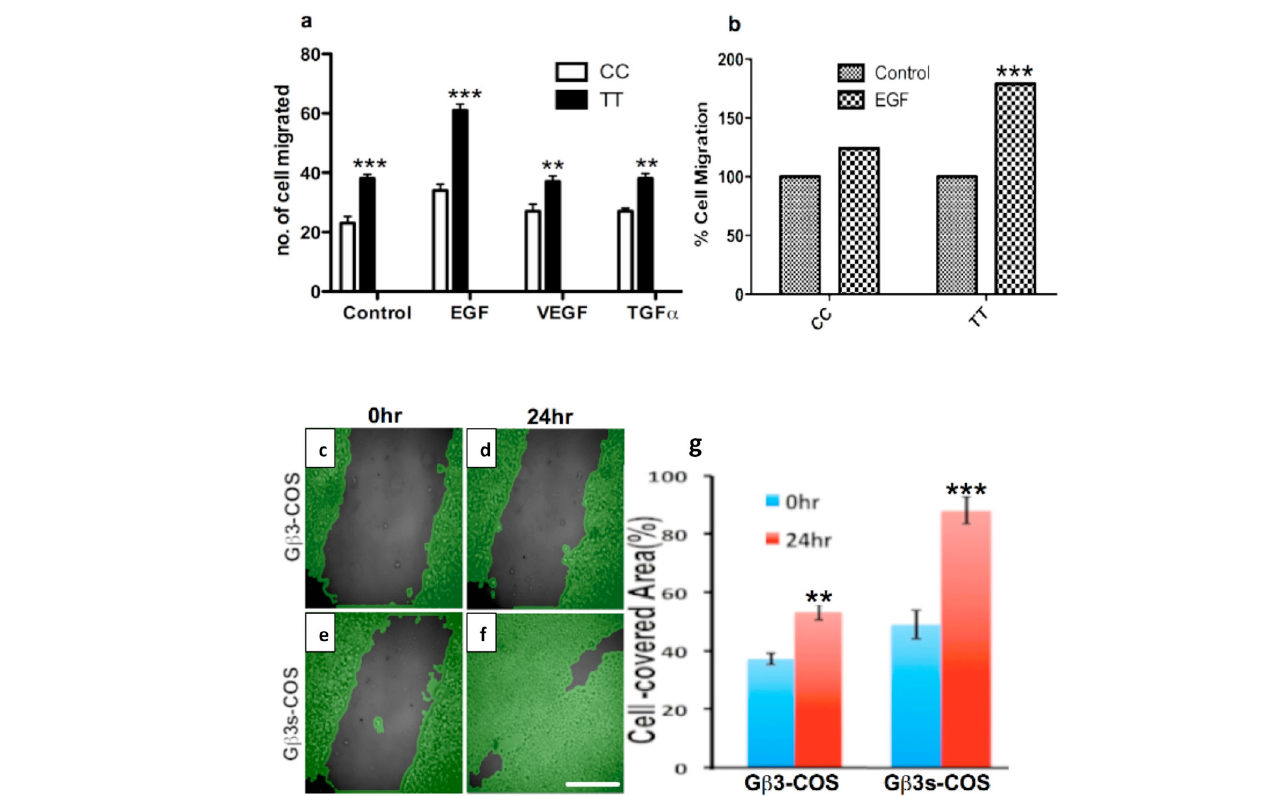
Figure 8. The presence of Gβ3s subunit enhances cell migration. CC and TT lymphoblastoids were either left untreated, or treated with growth factors and subjected to boyden chamber based chemotactic migration assay to examine their relative differences in migration. EGF, TGF a and VEGF stimulated enhanced chemotactic migration of serum starved TT lymphoblast cells as compared to CC (a). Control refers to 5% BSA stimulation in both CC and TT lymphoblast cells. The percentage of cell migration upon EGF stimulation is high in TT when compared to CC (b). Data presented in all panels are the mean with standard error (bars) of n = 3 independent experiments performed in octuplets. Statistical significance is shown as * P<0.05, **P<0.01, ***P<0.001. For scratch wound assays (c-g), scratches were made with a fine tip on coverslips containing stable clonal adherent G b 3 and G b 3s COS-7 cell lines. COS-7 stable clone expressing G b 3s subunit showed greater gap closure 24hr post scratching (c & d) when compared to COS-7 stable clones expressing normal G b 3 subunit (e & f). Graphical representation of % area covered by cells following 24hr of wound healing (h). These images are taken from different fields of view under a 5x objective with further 1.5x magnification. Bar = 100 m m. WIMASIS analysis tool was used to measure area covered by cells as mentioned in the methods section (e). Data presented in all panels are the mean with the standard error (bars) of n = 3 independent experiments. Statistical significance is shown as *P<0.05, **P<0.01,